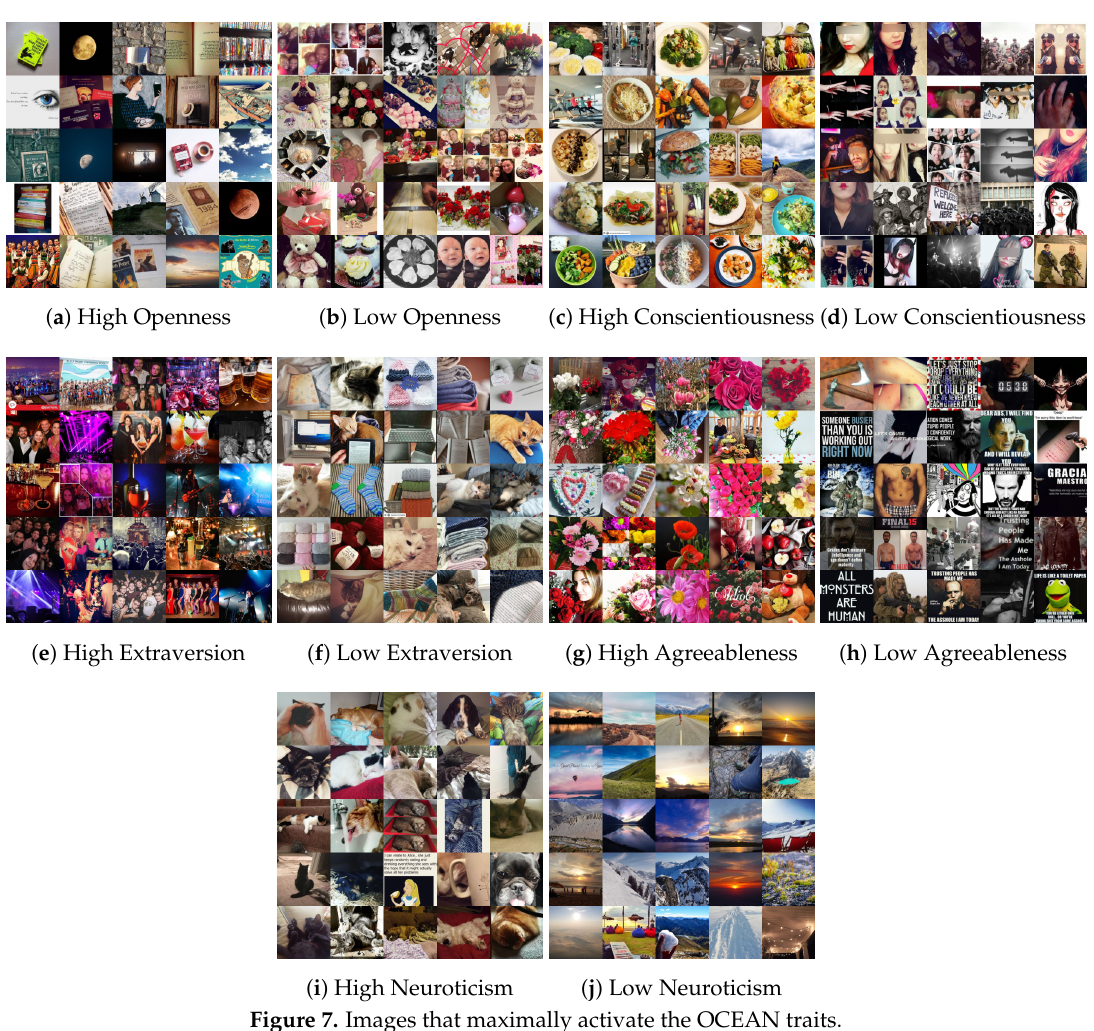
Figure 7. Images that maximally activate the OCEAN